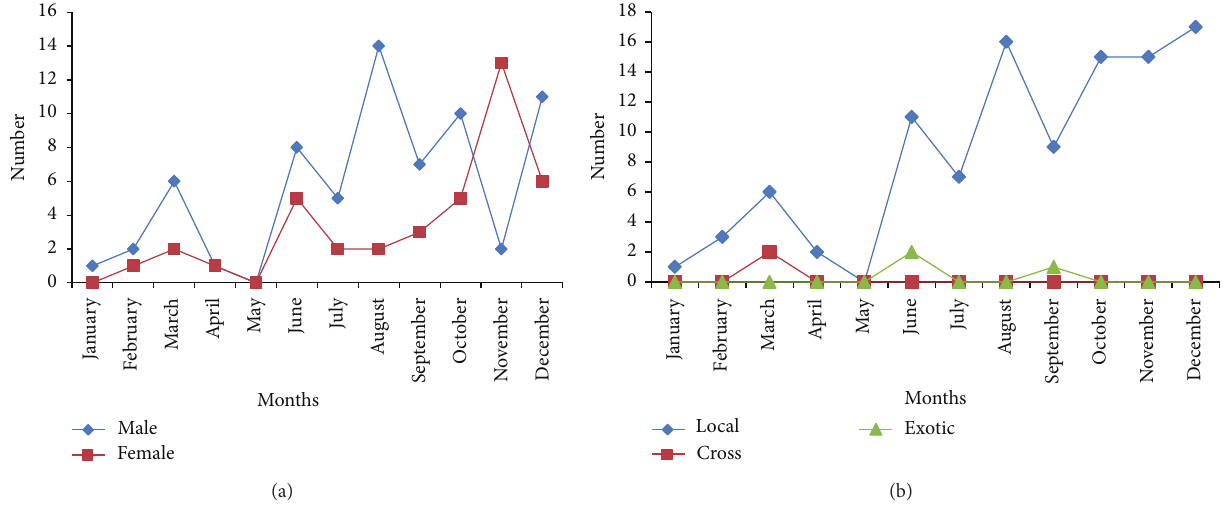
Figure 4: (a) The monthly distribution of Linguatulosis in dogs according to sexes in Jalingo, North Eastern Nigeria, for the year 2011. (b) The monthly distribution of Linguatulosis in dogs according to breeds in Jalingo, North Eastern Nigeria, for the year 2011. Table 1: The prevalence of Linguatula serrata in dogs in Jalingo, North Eastern Nigeria.